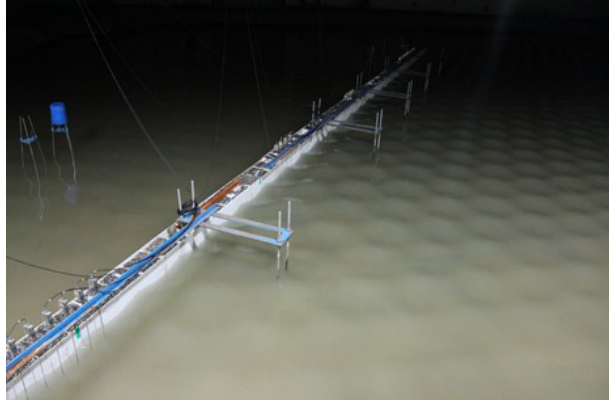
Figure 6. Wave pattern in front of a vertical wall ( θ 0 = 30 ◦ ).